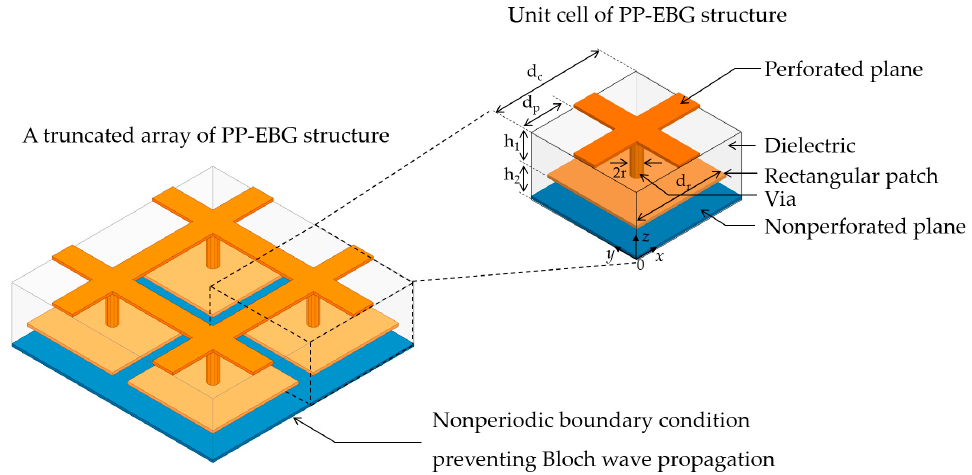
Figure 1. A truncated electromagnetic bandgap (EBG) structure with finite array size, resulting in a nonperiodic boundary condition.